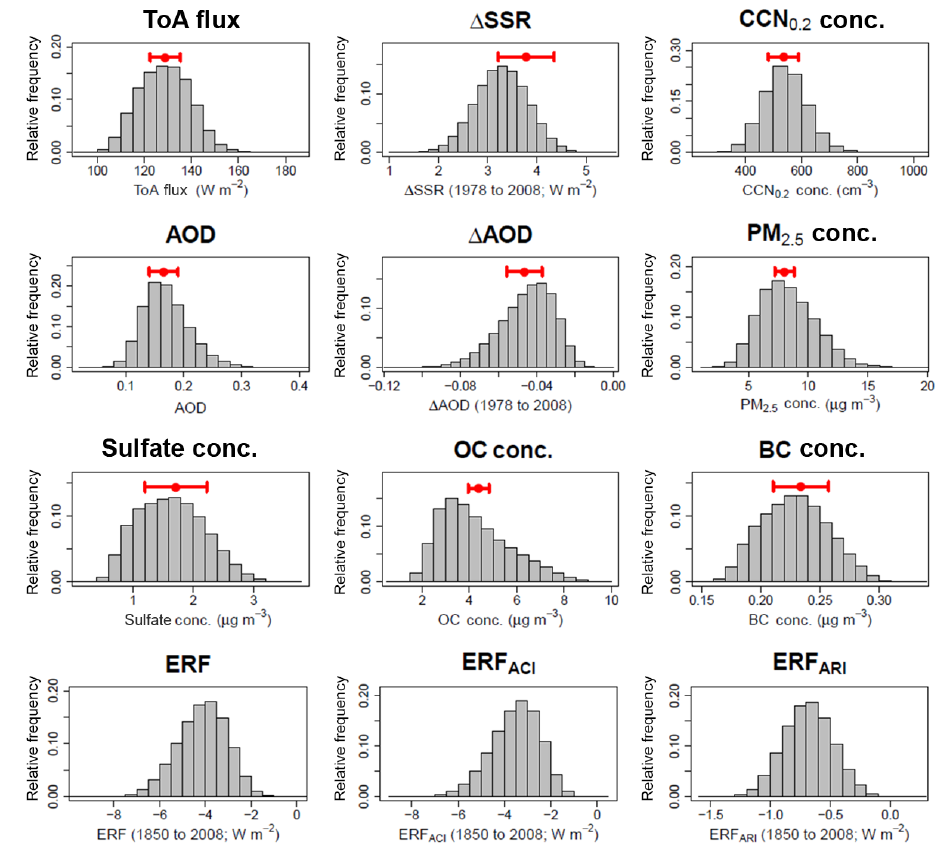
Figure 3. Calculated uncertainty in the aerosol quantities and aerosol ERF terms from the 4 million member sample. Results are for the July mean over Europe. The red bar shows the assumed range of each synthetic observation used to constrain the uncertain parameter space and the aerosol forcing uncertainty from Table